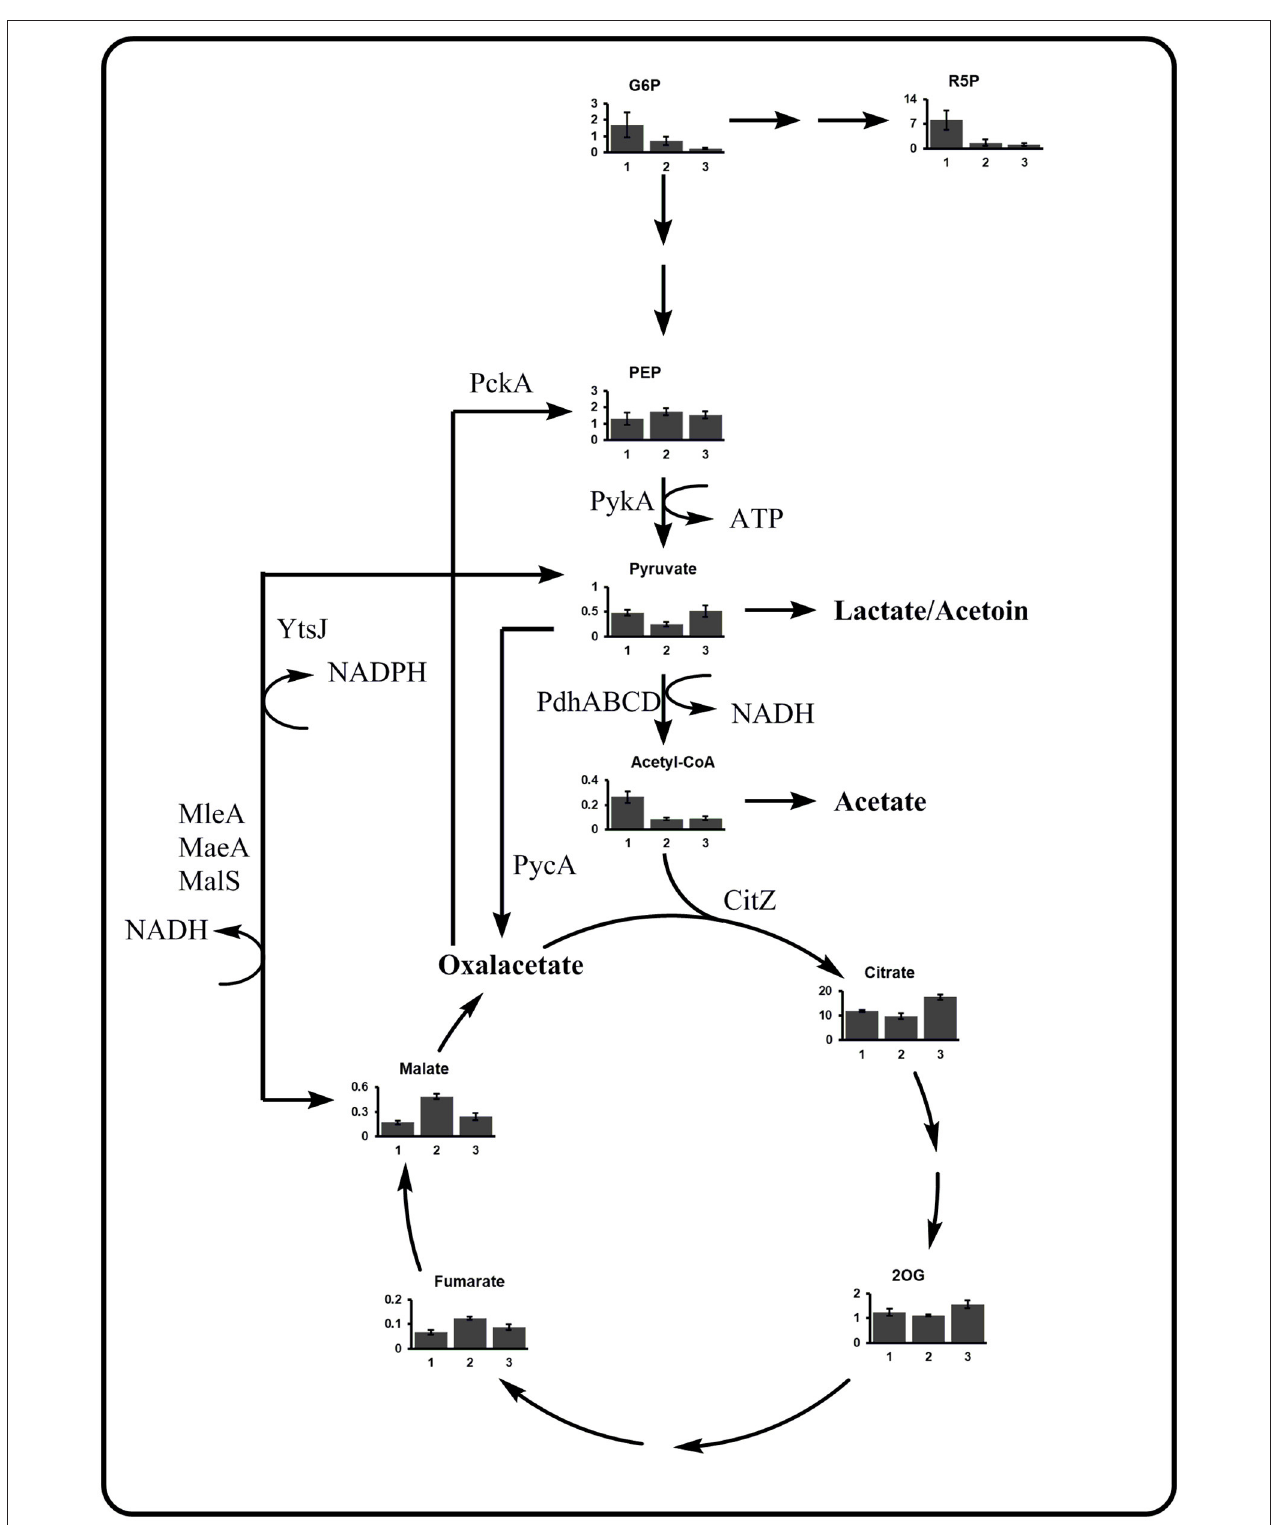
FIGURE 6 | Metabolic profile of the PEP-pyruvate-oxaloacetate node for B. subtilis WB growing on xylose. The metabolite concentrations from the central carbon metabolism for the three growth phases as indicated in 4 are given. Samples were taken after 9, 11, and 14h for phase I, II, and III, respectively. Cultivations were